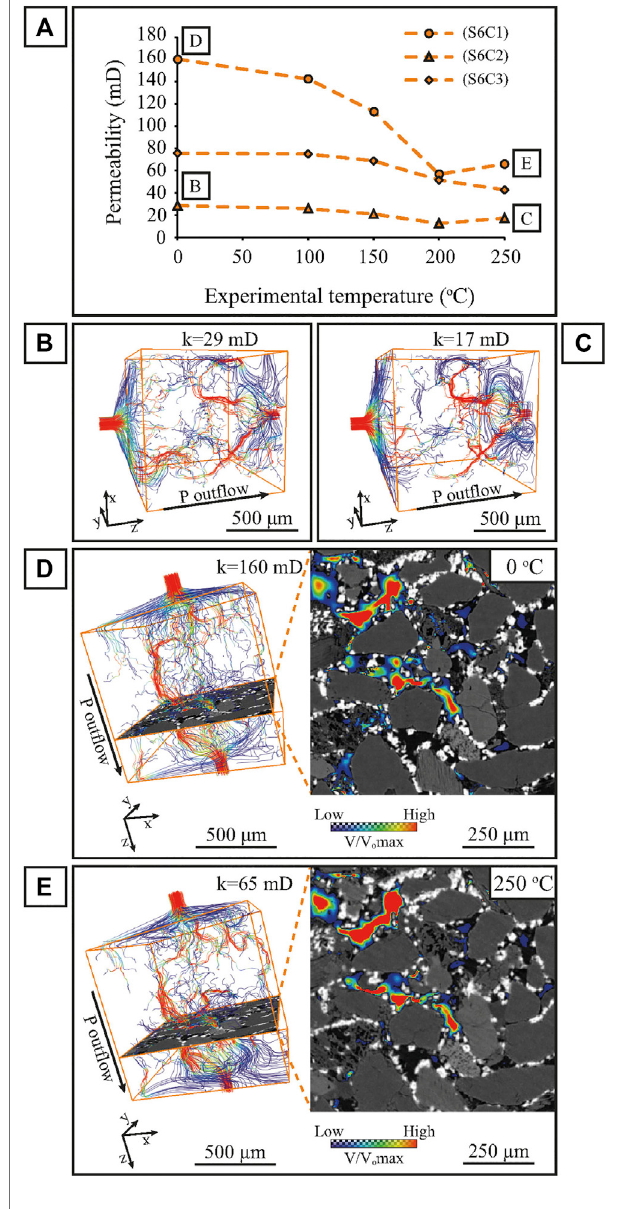
FIGURE 7 | APES of 500 voxel 3 subvolumes (S6C1-C3) extracted from sampleS6B. (A) Permeability evolutionwithincreasingtemperature. Themain reduction window lies between 150 and 200 ° C. (B) Permeability model of sample S6C2 prior and after (C) to hydrothermal treatment at 250 ° C. Red streamlines represent preferential fl uid fl ow pathways while blue indicate areas of reduced velocity magnitude. Color of streamlines shows the velocity normalized to the maximum velocity in the pre-treatment sample. (D) Pre- experiment permeability model of sample S6C1 with associated 2D velocity magnitude map. (E) Permeability model and 2D velocity magnitude map at 250 ° C. The maps are normalized to the maximum velocity value derived from the pre-experiment permeability simulation. Permeability reduction is attributed to the extinction of low-velocity magnitude pathways, mainly associated with microporous